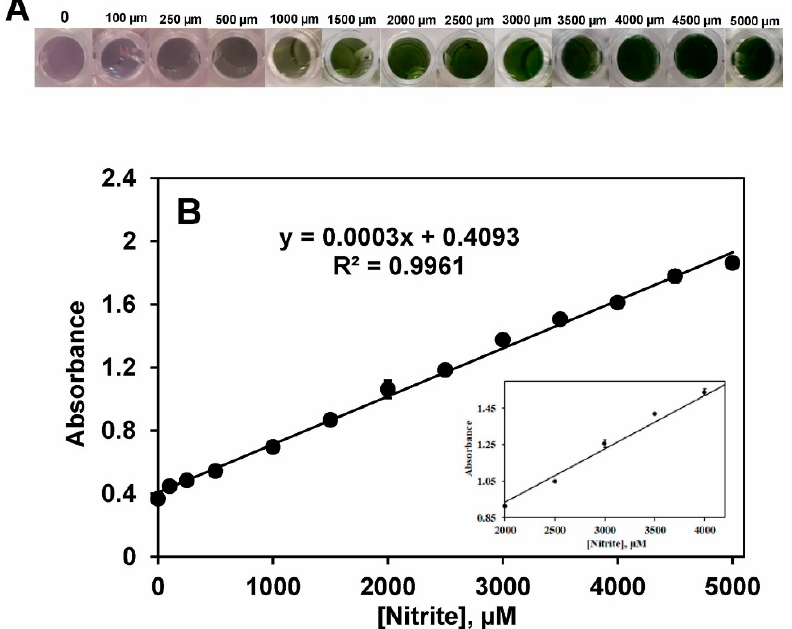
Figure 3. ( A ) Photographic colorimetric response of the AuNP ‐ CeO 2 NP@GO nanozyme to nitrite detection at different incubation times and the corresponding catalytic absorbance signals generated at the different detection times ( B ). Reprinted with permission from [28]. Copyright © 2020 Elsevier.